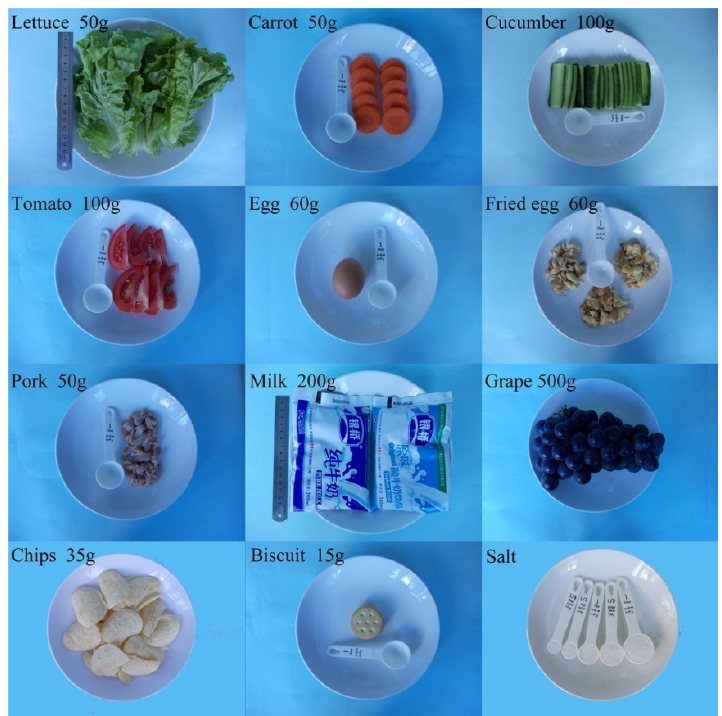
Figure 2. Reference pictures of a small part of food items with household measuring tools in this